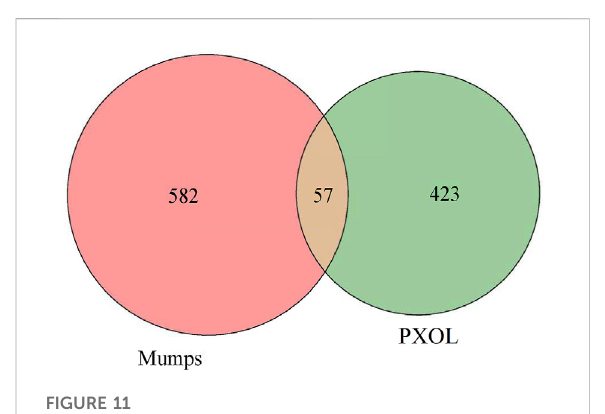
FIGURE 11 Mumps – PDL intersection